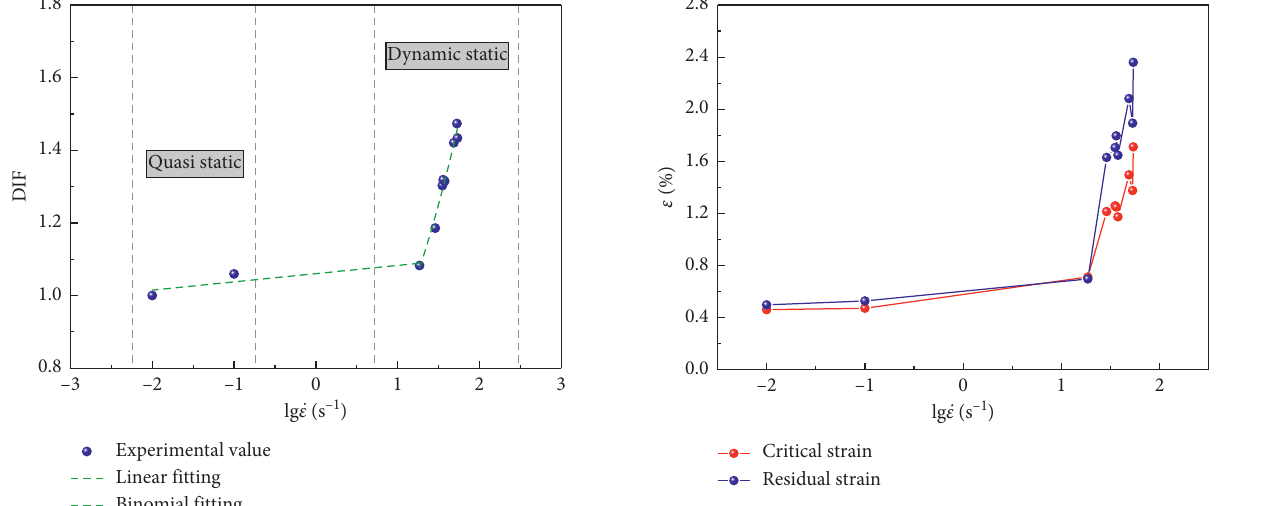
Figure 7: Relationship between deformation and logarithmic form of the strain rate. Figure 6: Strain rate effect on the uniaxial compressive